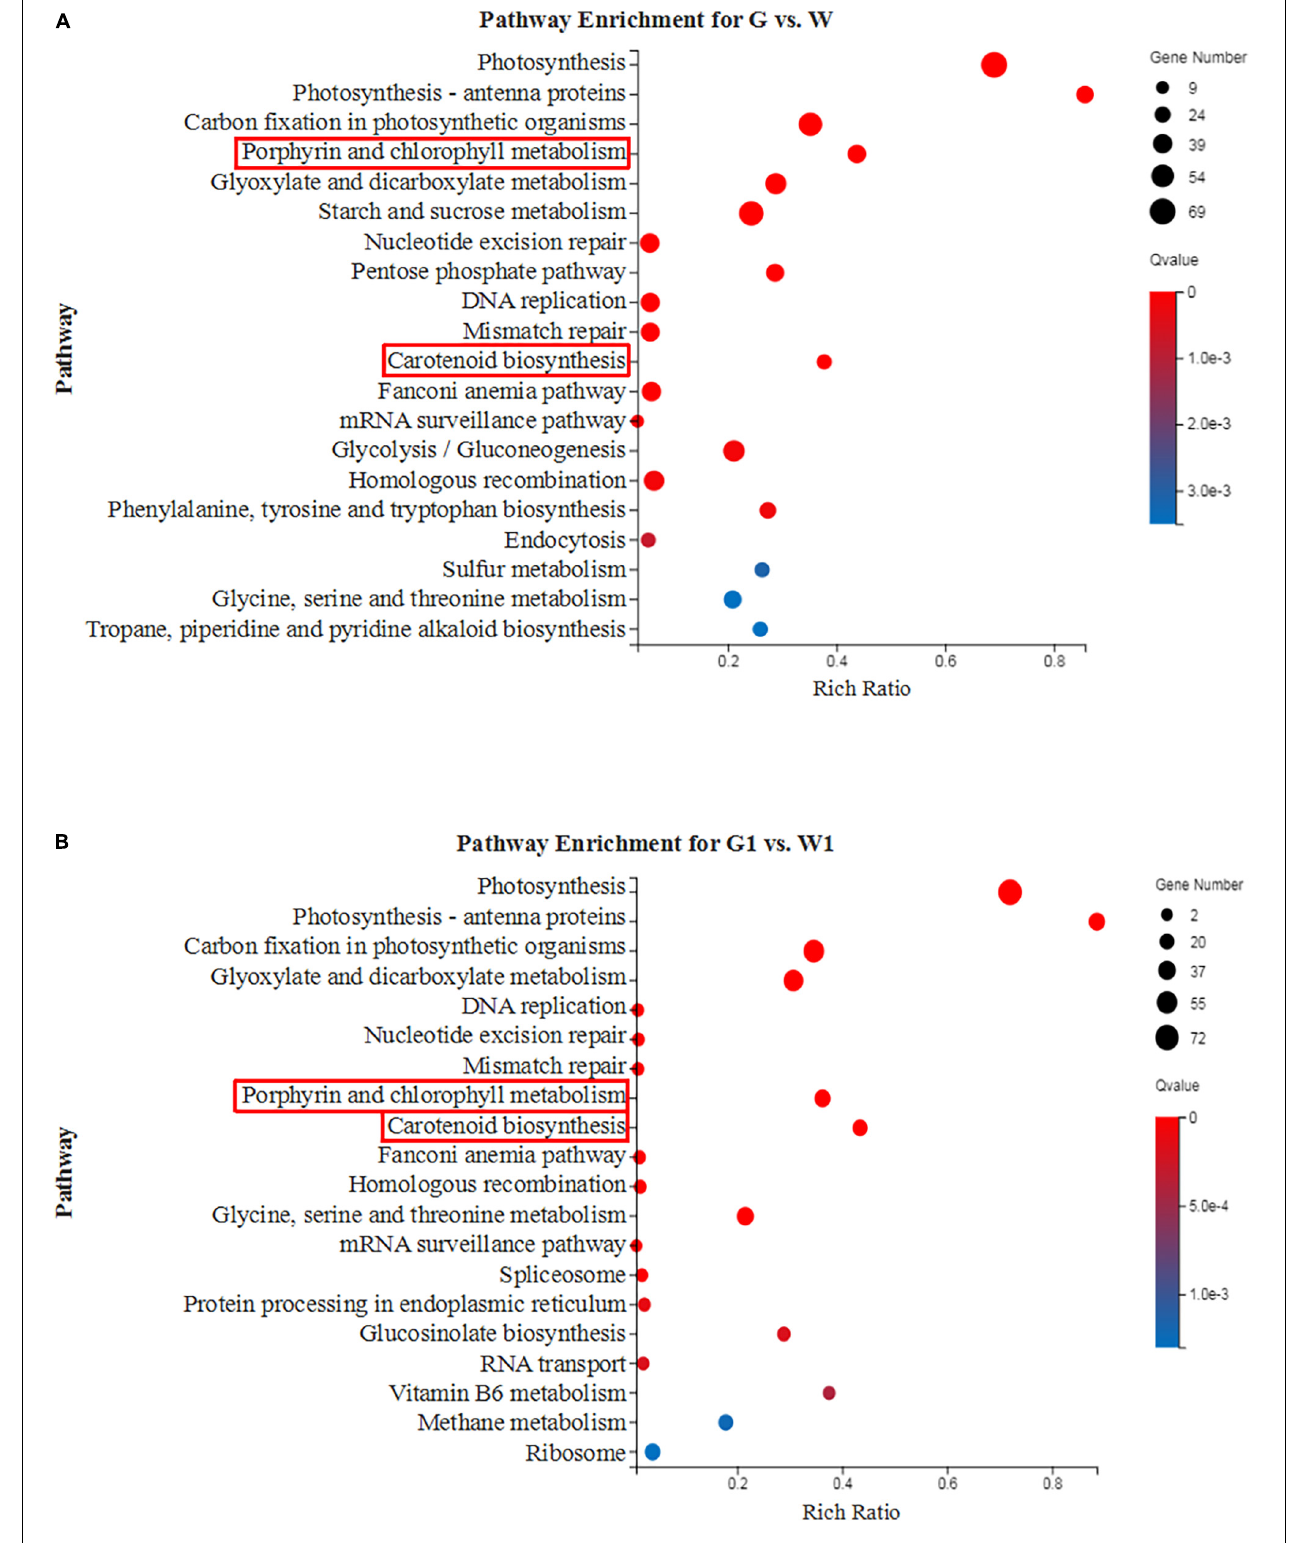
FIGURE 3 | The top 20 enriched KEGG pathways of the DEGs between green and white kale leaf tissues. (A) G vs. W and (B) G1 vs. W1.